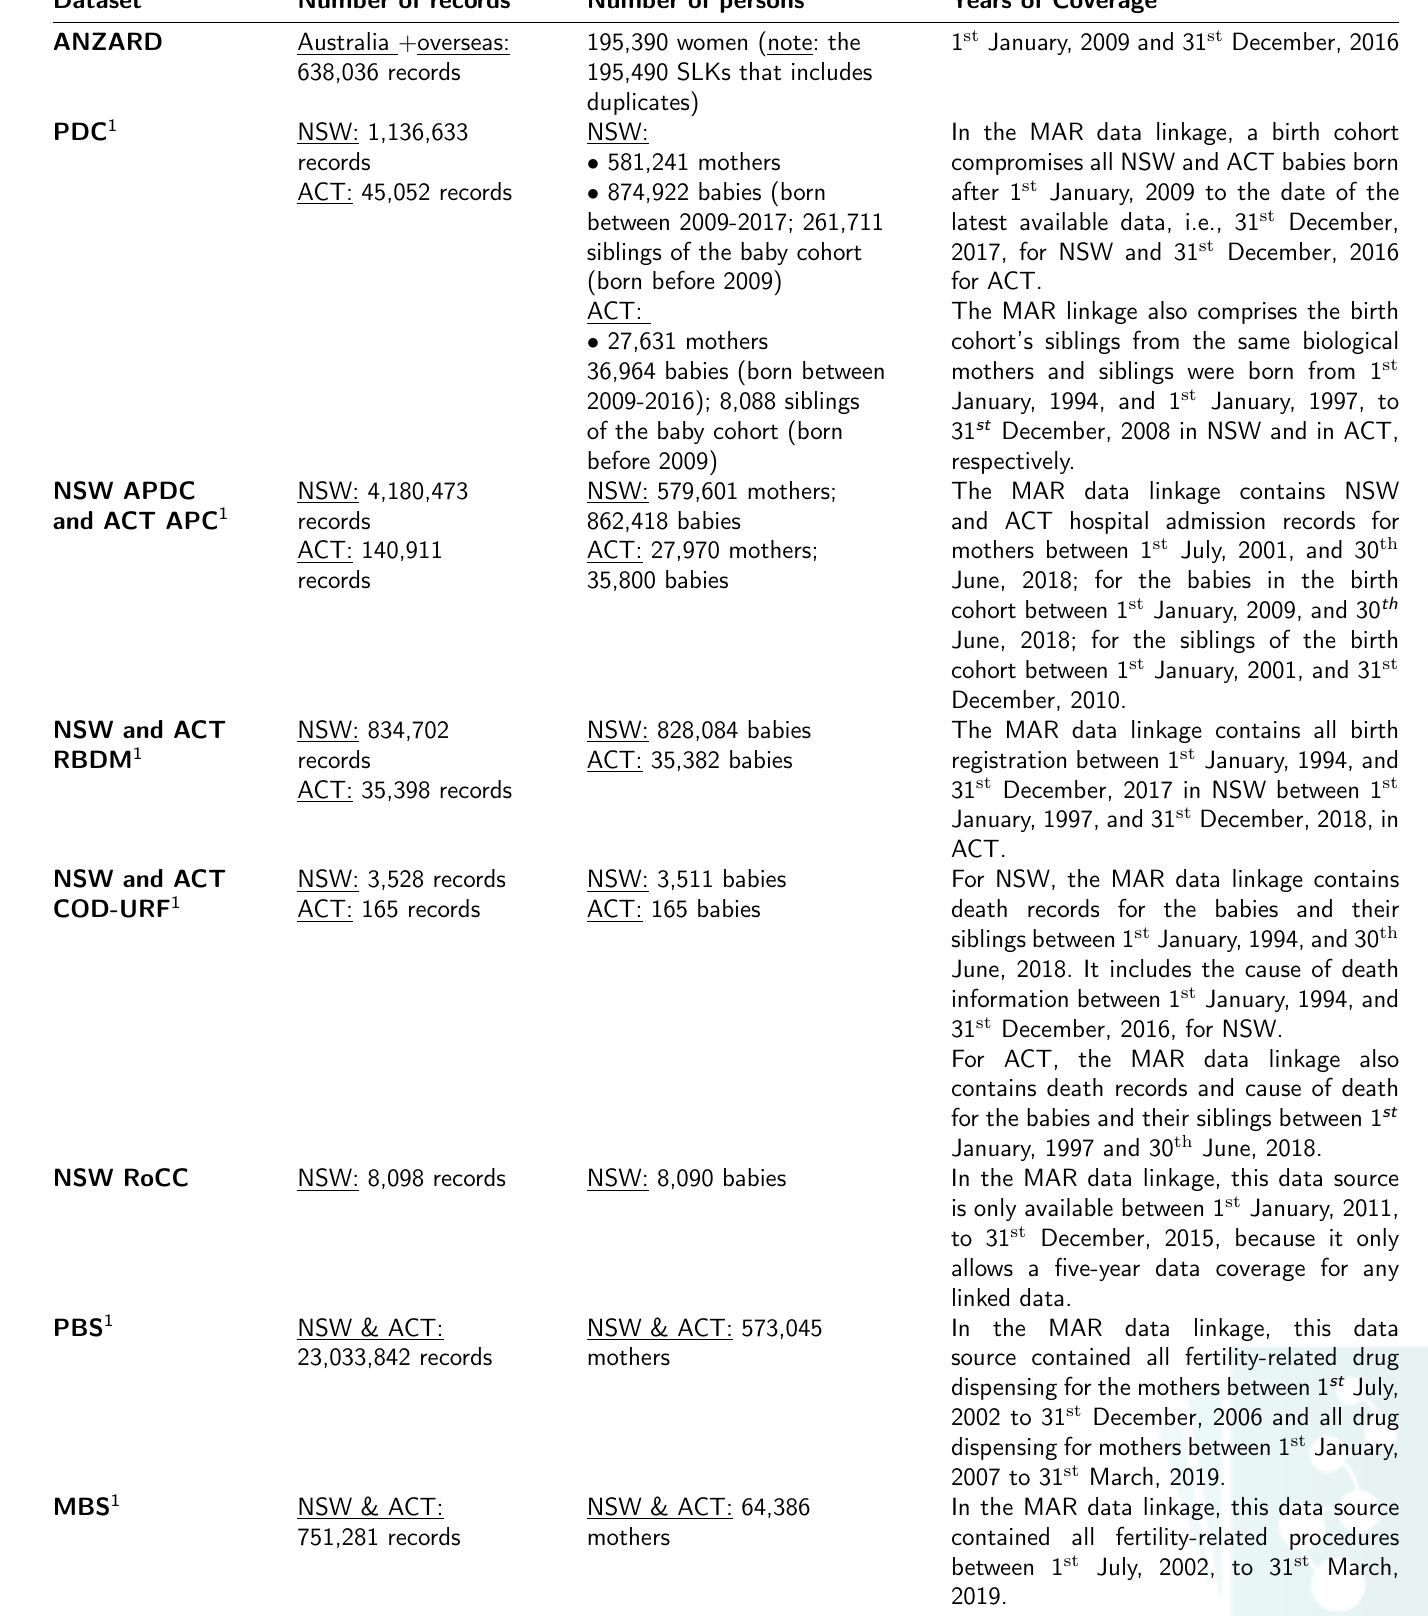
Supplementary table 1: Details for each data sources in the medically assisted reproduction (MAR) data linkage, by New South Wales and Australian capital territory